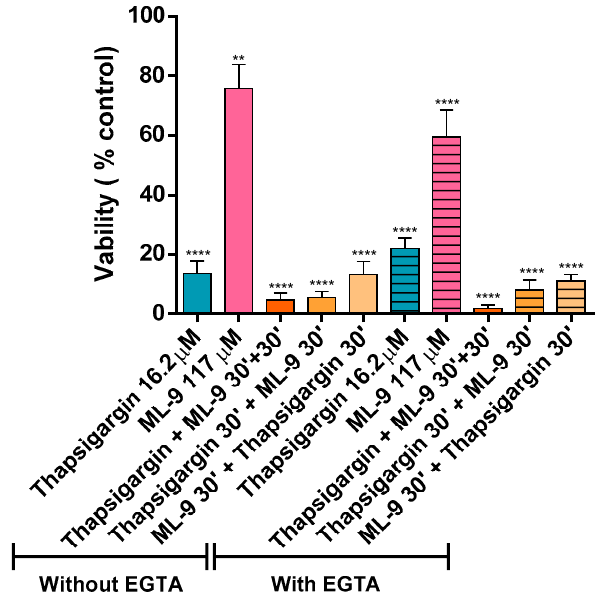
Figure 6. Thapsigargin and ML-9 effects on human neutrophils viability. Effect of 1 h exposure of human neutrophils to thapsigargin (16.2 µ M), ML-9 (117 µ M) and their mixture on cells’ viability, in the absence or presence of EGTA (800 µ M), assessed by the trypan blue exclusion method. Values are given as the mean ± SEM ( n ≥ 3). ** p ≤ 0.01 and **** p ≤ 0.001, compared with the control assay (without thapsigargin and ML-9).